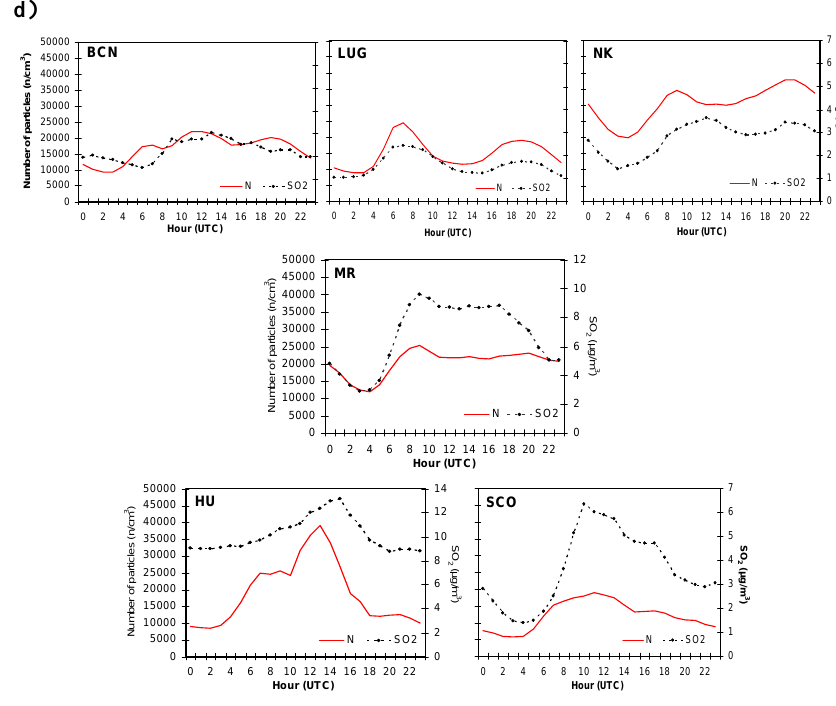
Figure 2. Daily cycle of: a) Gaseous pollutants concentrations (CO, NO X and O 3 ), b) Black 1146 carbon (BC) and Number concentration (N), c) BC and PM 10 , and d) N and SO 2 levels for 1147 each monitoring site. 1148